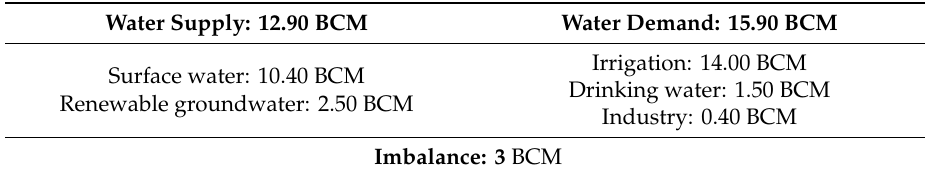
Table 2. Average water supply/demand in Morocco from 2010 to 2017.